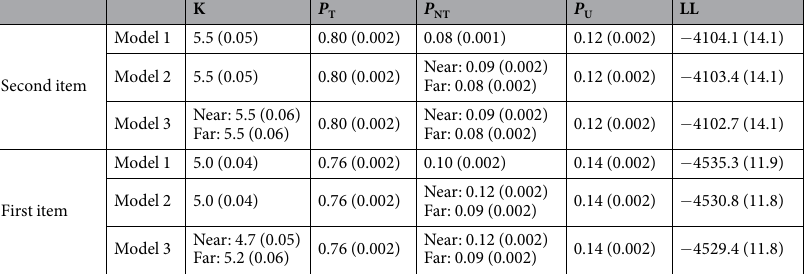
Table 6. Estimates from the mixture models for Experiment 5, calculated using a model in which neither K nor P NT could differ between Near and Far conditions (Model 1), a model in which only P NT could differ (Model 2) and a model in which both K and P NT could differ (Model 3). The 95% confidence interval is shown in parentheses, which was found by bootstrapping the data 100 times. LL denotes the log